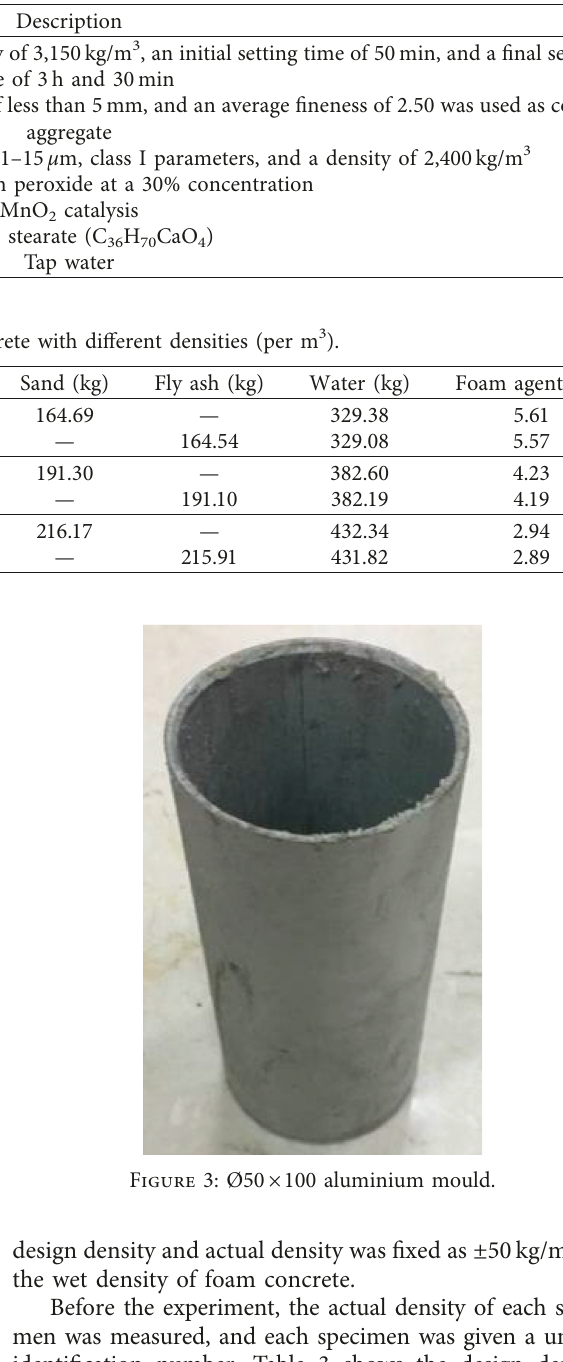
Table 1: Materials used and their descriptions.